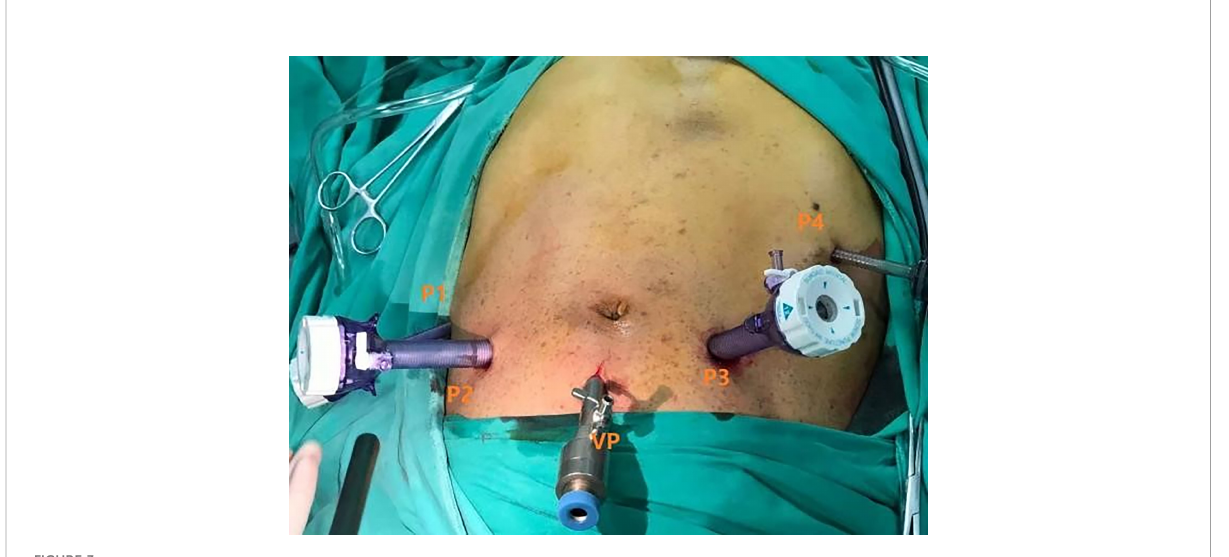
FIGURE 3 Laparoscopic port placement.